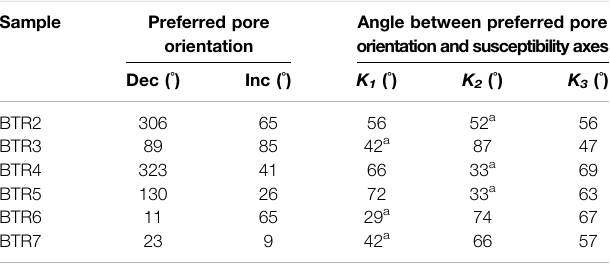
TABLE 3 | Preferred pore orientation and the angle between preferred pore orientation and either K 1 , K 2 , or K 3 . Sample